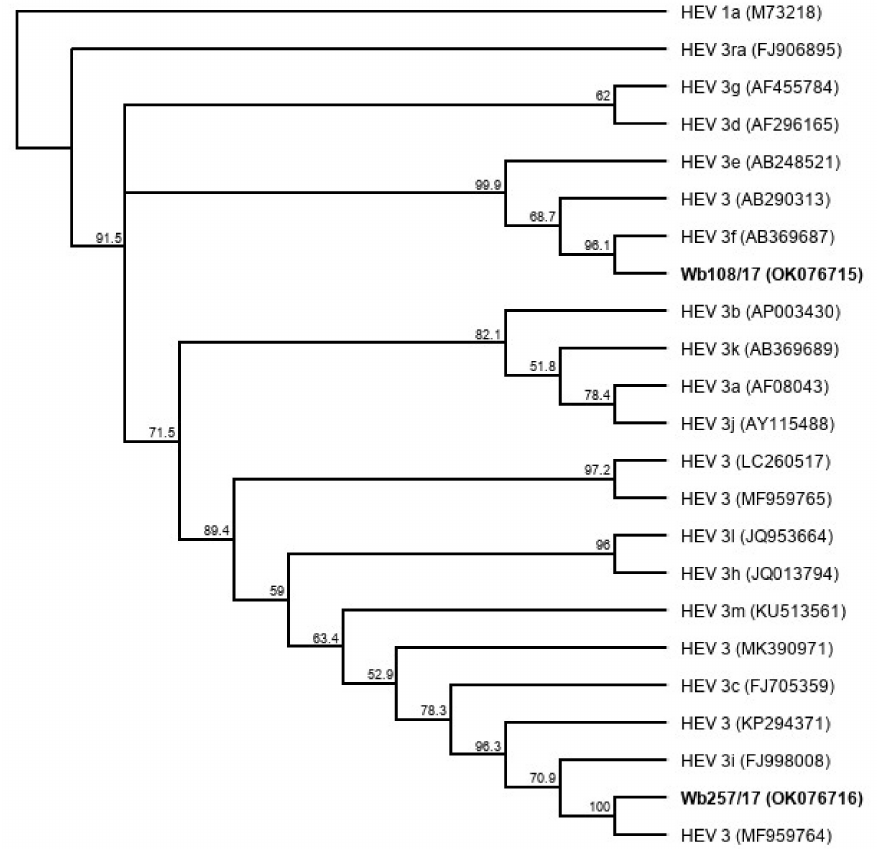
Figure 6. Cladistic relationship of cell culture-isolated whole genome sequences of HEV from wild boar samples Wb108/17and, Wb257/17 (highlighted in bold) and proposed HEV GT3 subtype reference sequences [27]. The tree was constructed from a MUSCLE nucleotide alignment using the neighbor-joining method and 1000 bootstrap iterations and rooted with HEV 1a. Bootstrap values >50% are